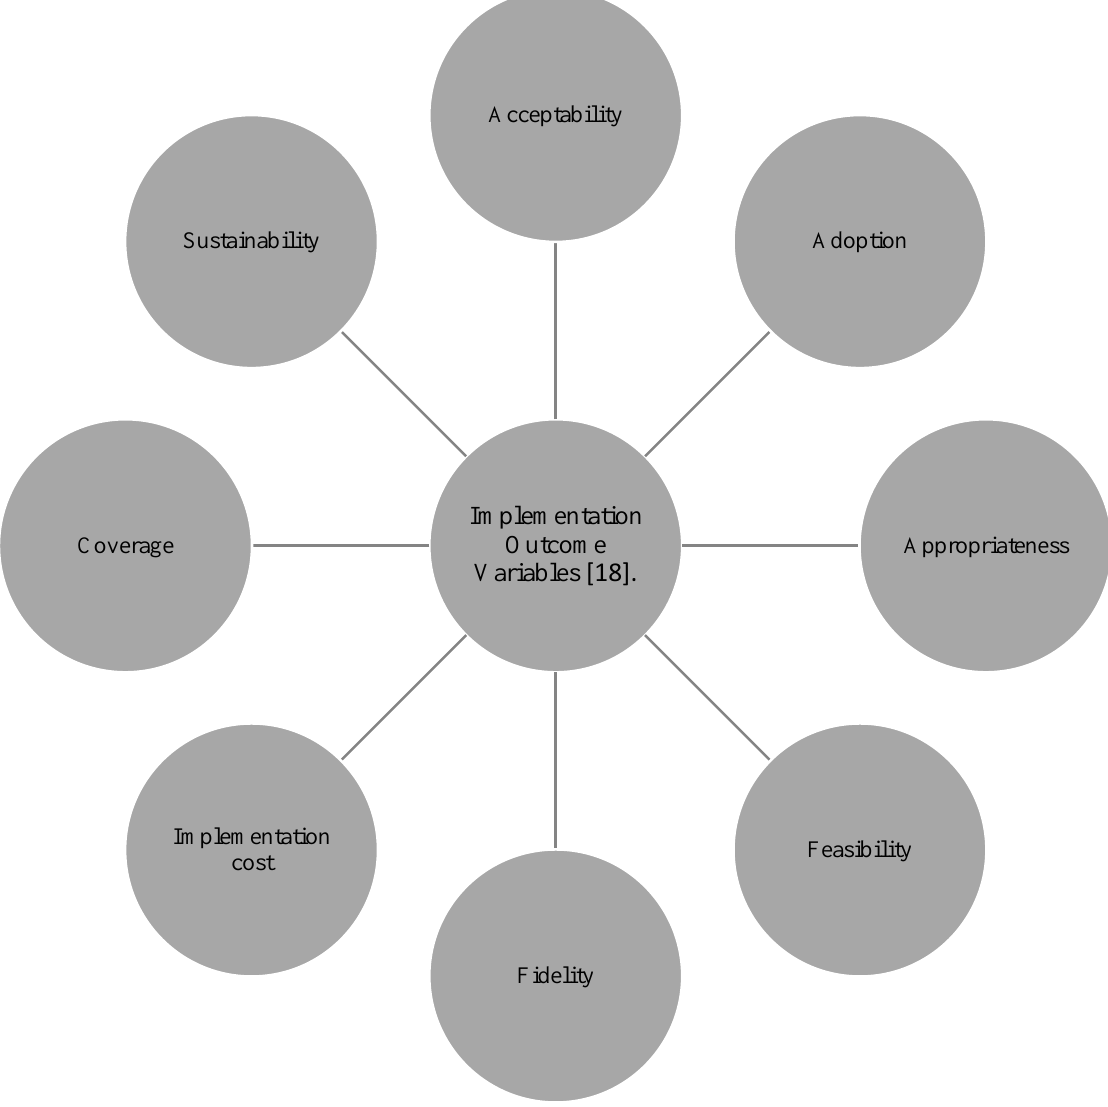
Figure 1. Implementation Outcome Variables [18].